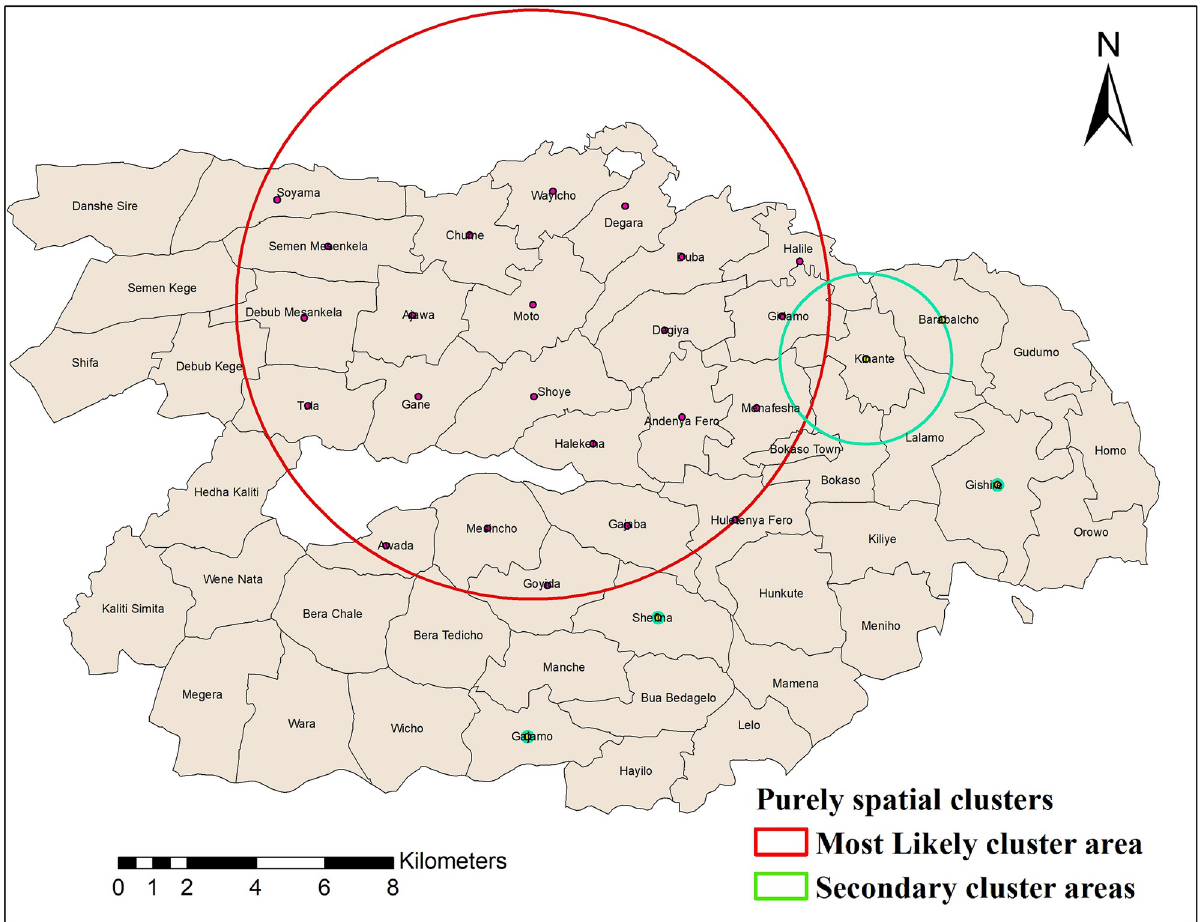
Fig 4. Purely spatial clustering of low health service utilisation in Dale and Wonsho districts, Sidama, Ethiopia, 2017/18.